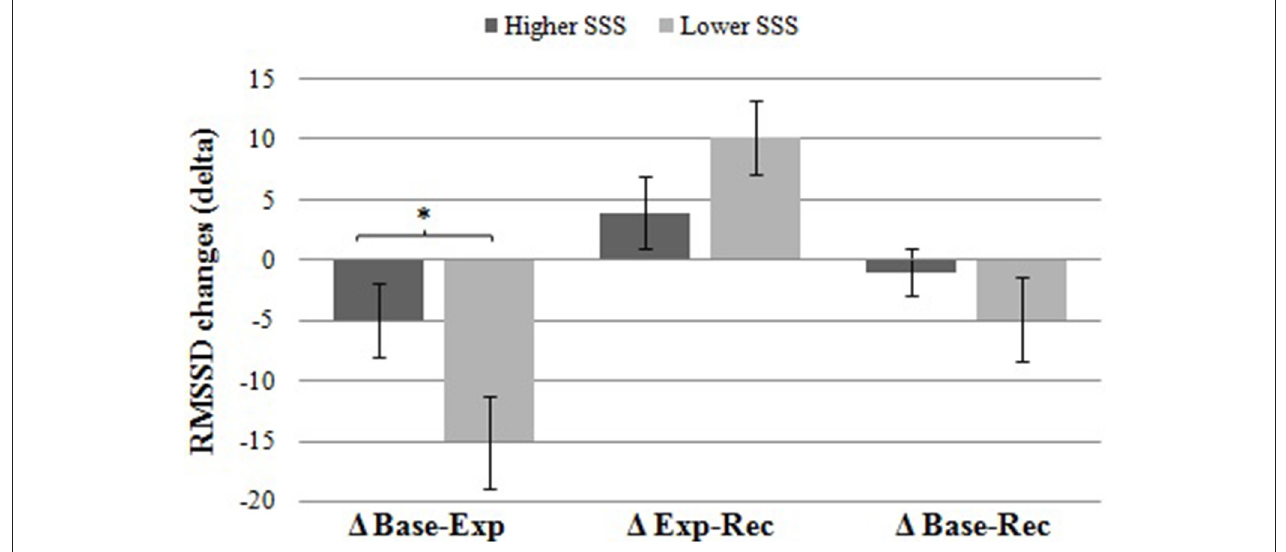
FIGURE 1 | Differences in HRV (RMSSD) reactivity between groups. Participants in the low SSS group showed a significantly higher RMSSD decrease ( ± SE) from baseline to experimental manipulation compared to participants in the high SSS group. There were no significant group differences in change from experimental manipulation to recovery or from baseline to recovery ( p > 0.1). * p =